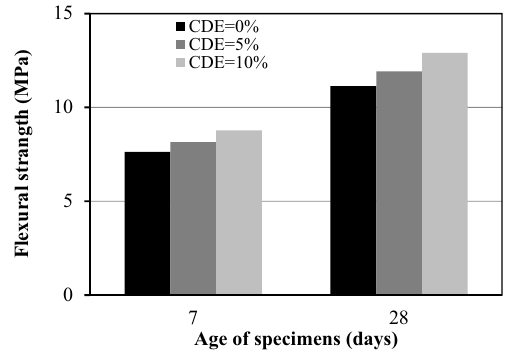
Figure 9: Flow of UHPC.